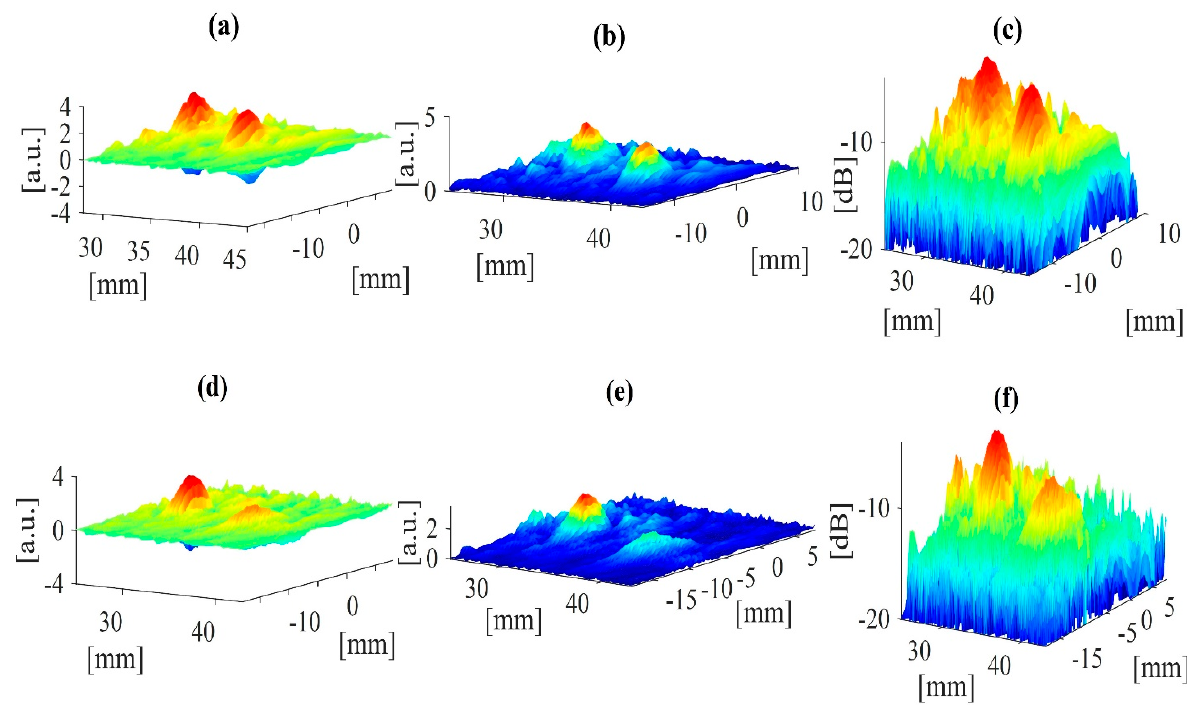
Figure 12. Surface image of the defects no.3 and no.4. ( a – c ) are the 3D demonstration of the TFM image shown in Figure 10, while ( d – e ) are the 3D demonstration of the TFM image shown in Figure 11.